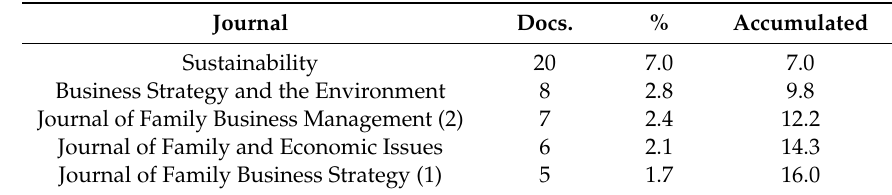
Table 3. Journals on Sustainability in Family Firms.